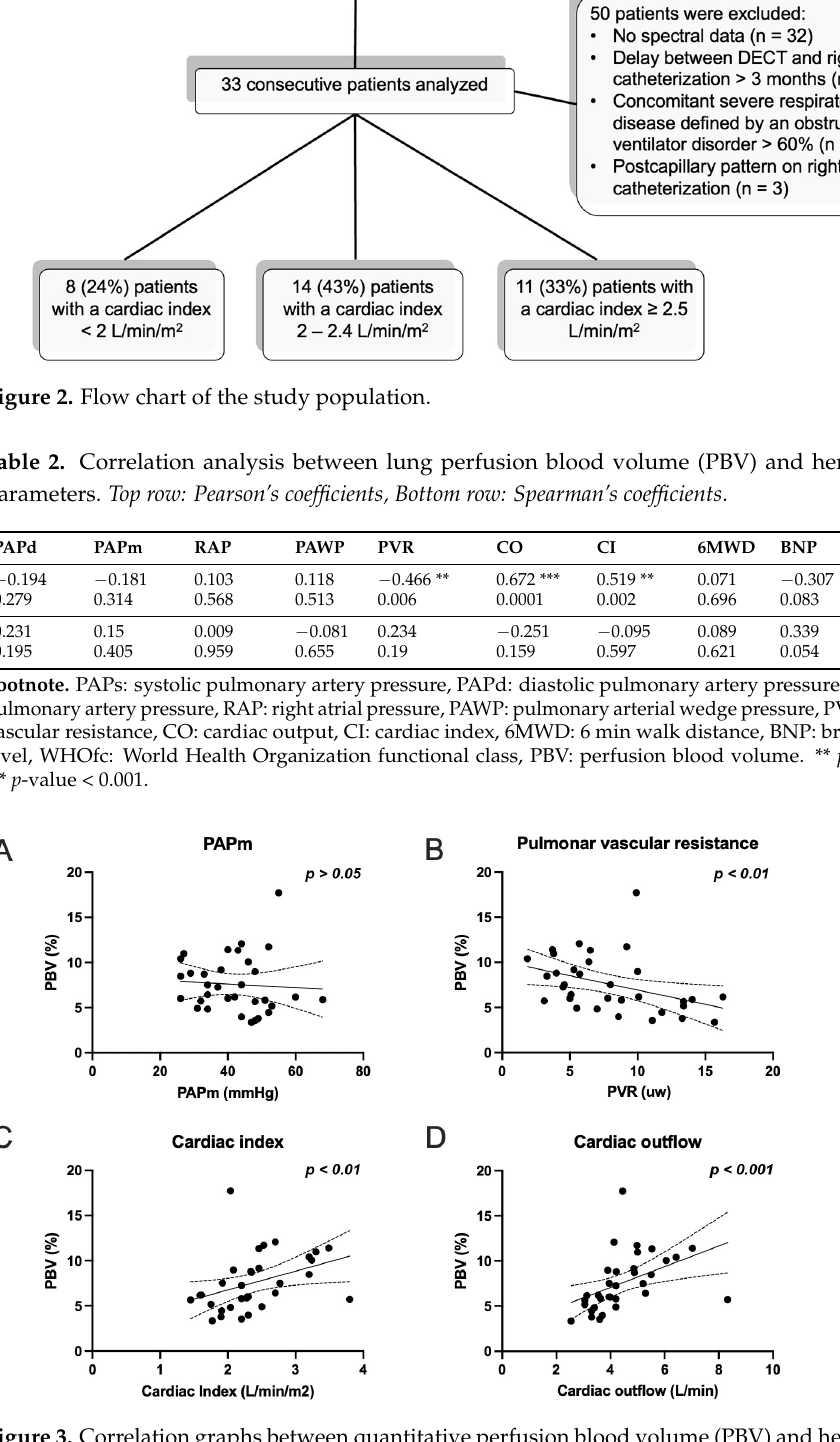
Figure 3. Correlation graphs between quantitative perfusion blood volume (PBV) and hemodynam-